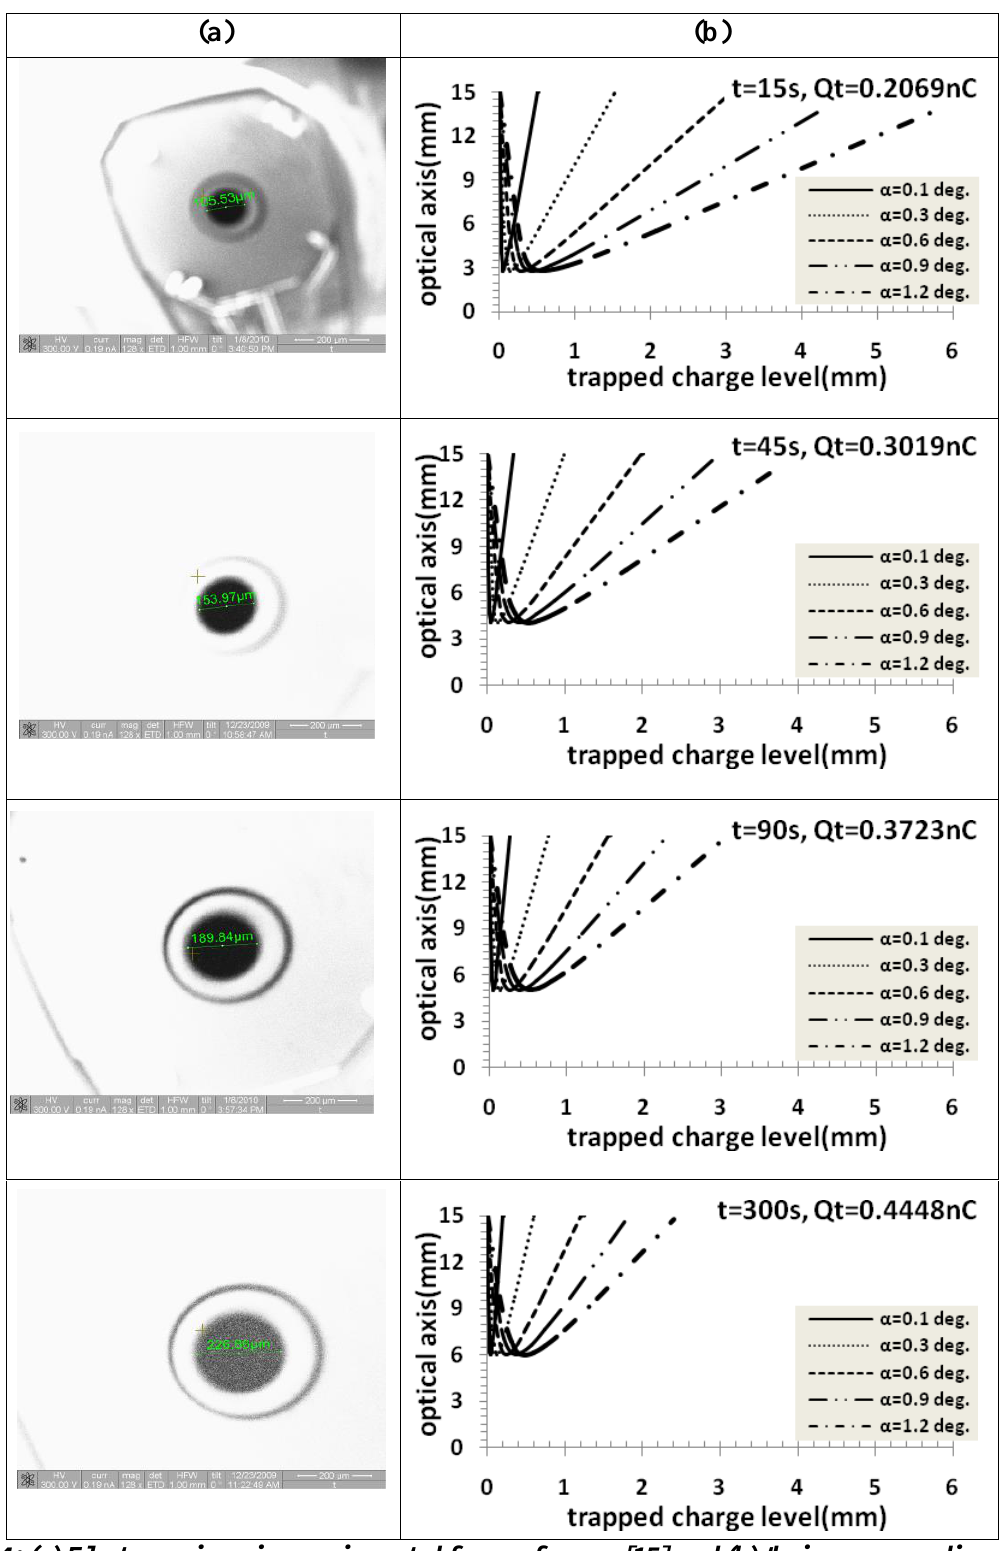
Fig. 4: (a) Electron mirror images imported from reference [15] and (b) their corresponding probing electron paths according to present